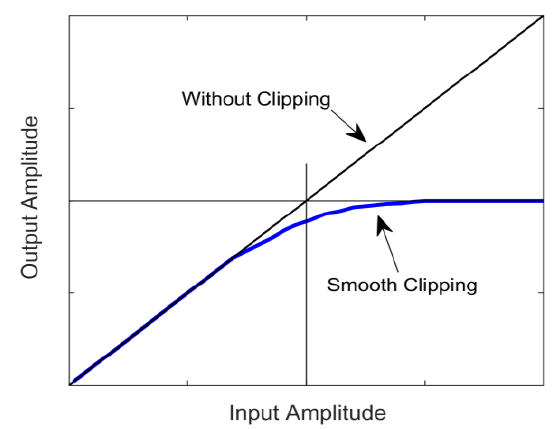
Figure 4. Smooth Clipping function.